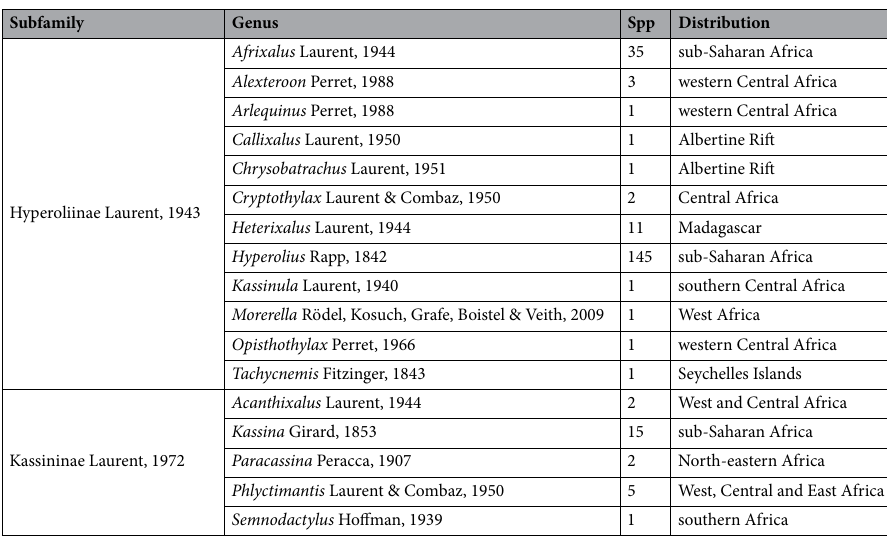
Table 1. Genera of the family Hyperoliidae, including their species richness and distribution 2 .